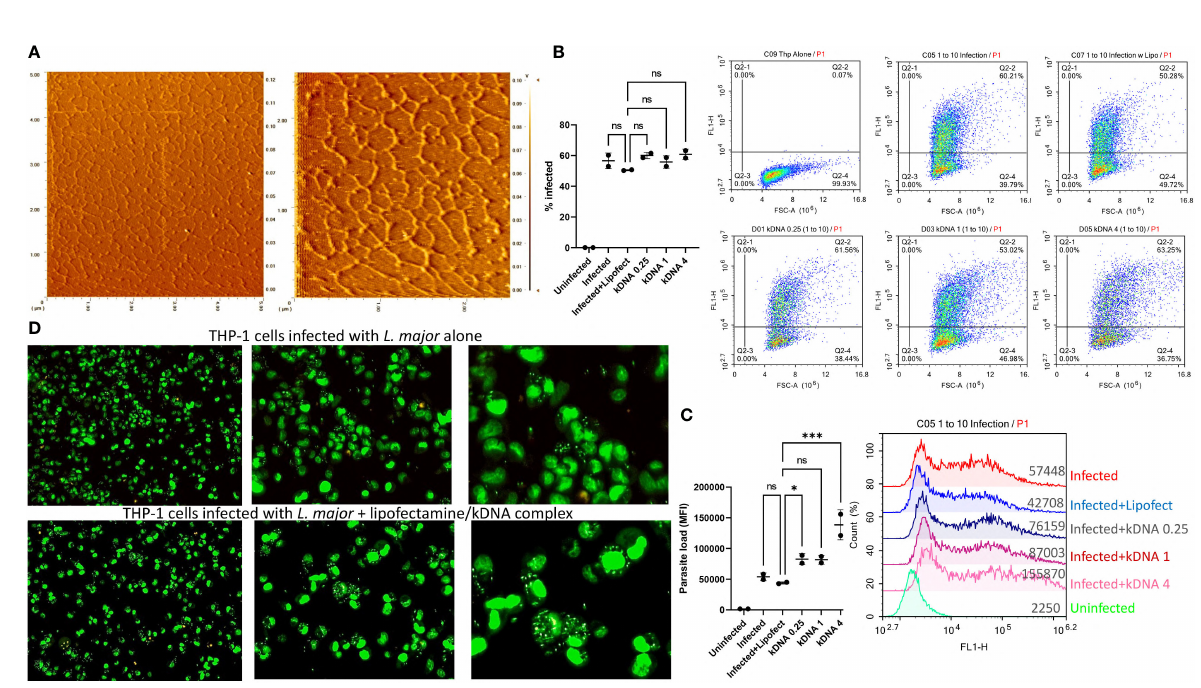
FIGURE 1 Effect of Cytosolic kDNA delivery on in vitro Leishmania infection. (A) AFM images of the puri fi ed kDNA networks with scanning areas of 5x5 m m (left) and 2.5x2.5 m m (right). PMA-differentiated THP-1 cells (5x10 5 cells/ml) were incubated with CFSE labeled parasites (5x10 6 parasites/ml) for 24 hours in the presence or absence of kDNA. Percentage of infected cells (B) and total parasite loads (C) were evaluated by fl ow cytometry. Numbers on x-axis labels indicate concentration of kDNA ( m g/ml). Data represent the average of two independent experiments ± SD. All groups were compared statistically by one-way ANOVA followed by Dunnet`s multiple comparison test. (D) Fluorescence microscopy images of infected, SYTO Green stained THP-1 cells (from left to right, 10X 20X and 40X) untreated (upper panels) or treated with 1 m g/ml kDNA. Images are representatives of two independent experiments. ns=not signi fi cant, *p ≤ 0.05, **p ≤ 0.01, ***p ≤ 0.001, ****p ≤